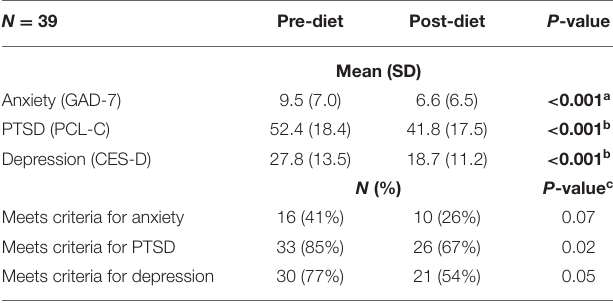
TABLE 1 | Change in psychological symptoms after 1-month on the low glutamate